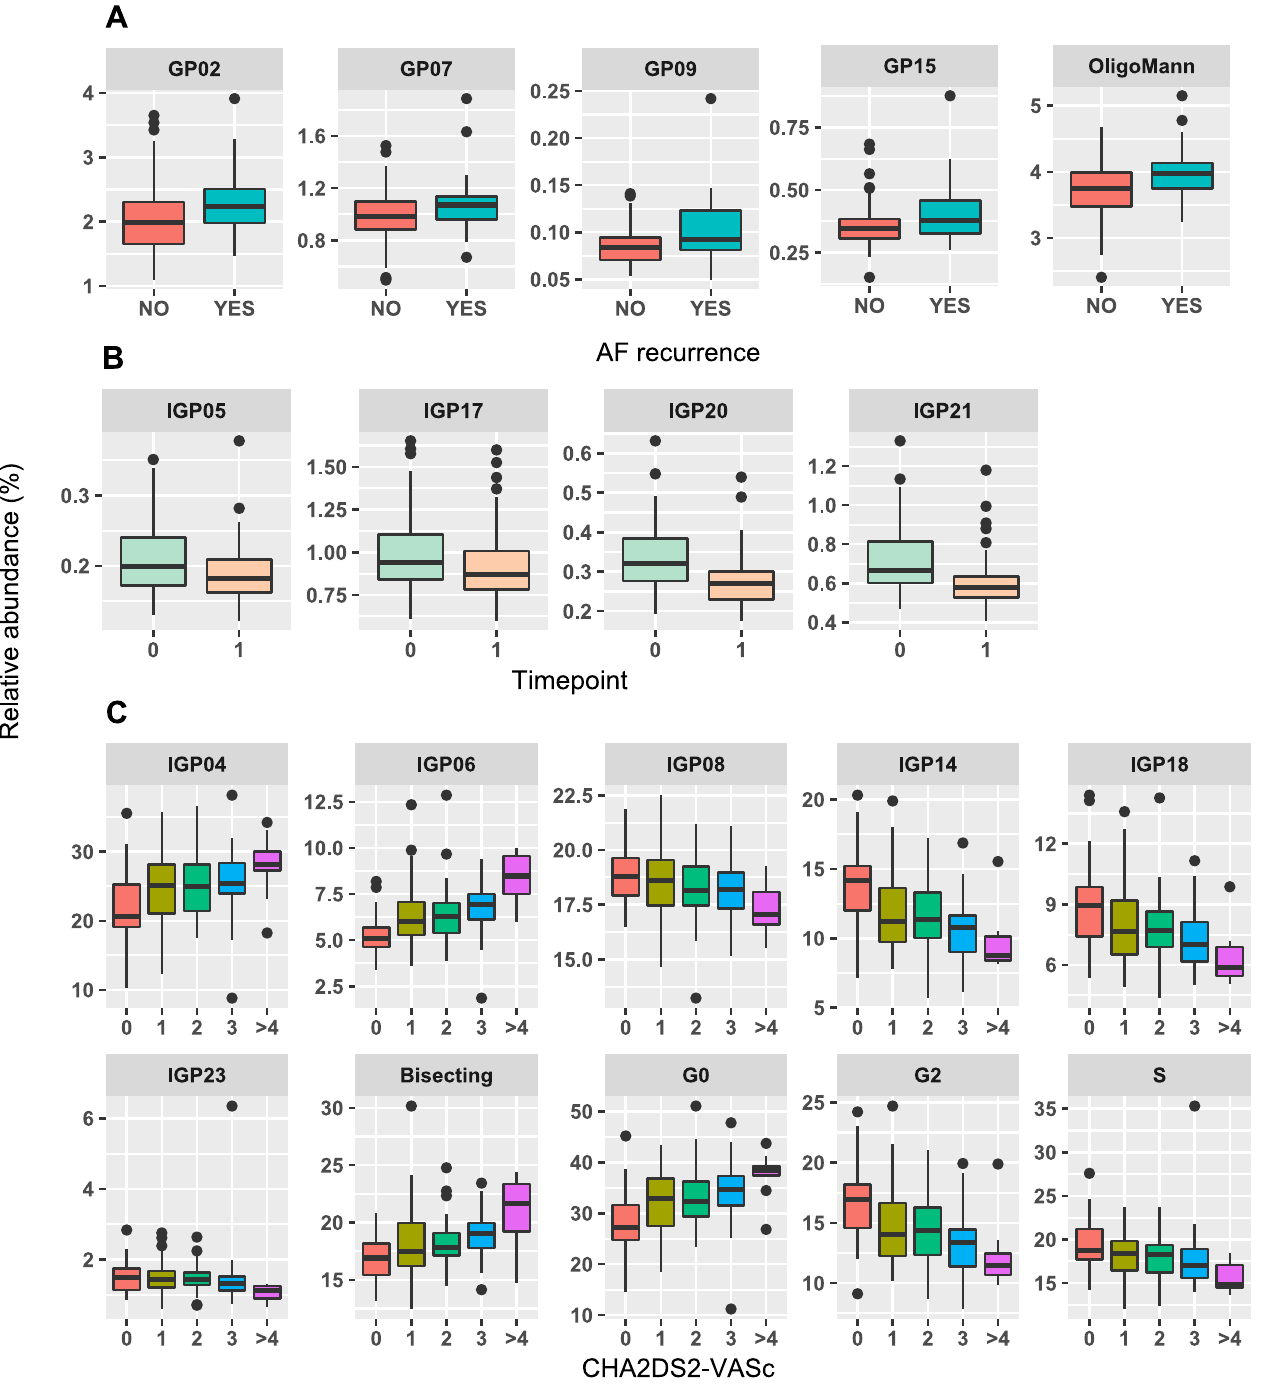
Figure 2. Association of total plasma protein N -glycosylation with AF recurrence ( A ). Association of IgG N -glycosylation between the pre- and post-procedure measurements ( B ). Association of IgG N -glycosylation with the CHA 2 DS 2 -VASc score ( C ). Data are shown as boxplots, as described in Figure 1. Only statistically significant structures and traits are shown.